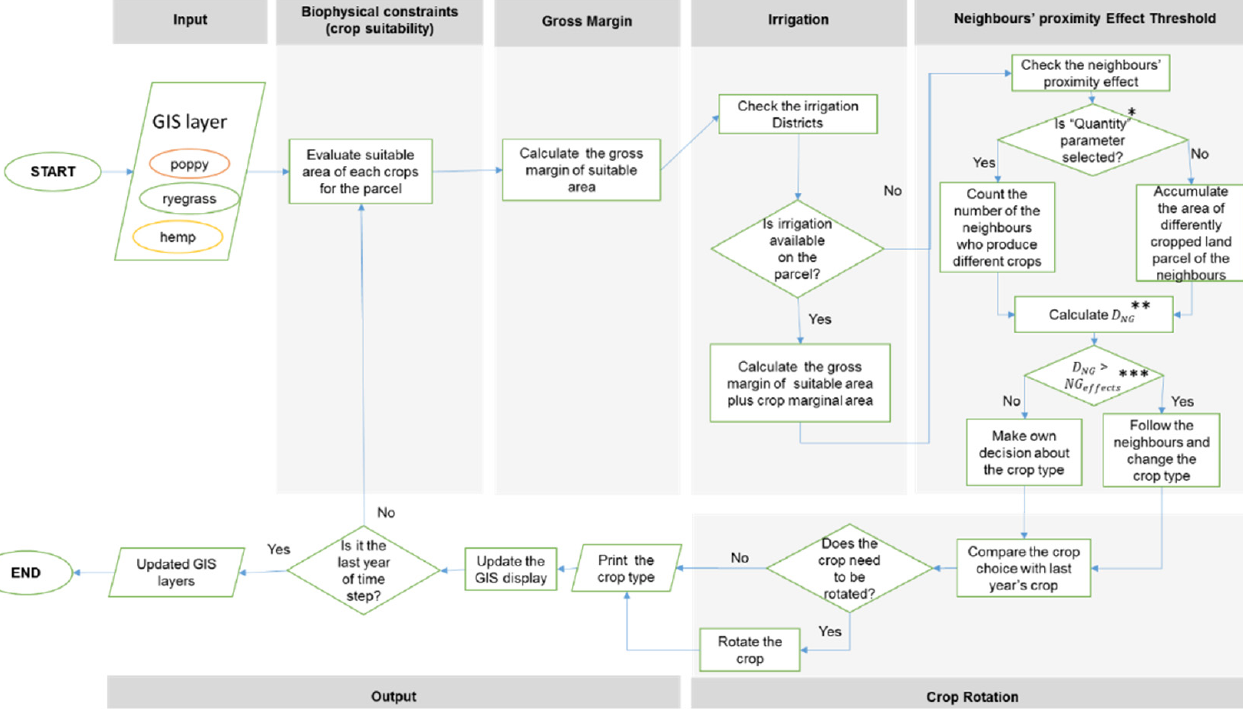
Figure 4. Detailed flowchart to determine the steps that farmers follow to decide on the farming system and crop rotation from year to year.